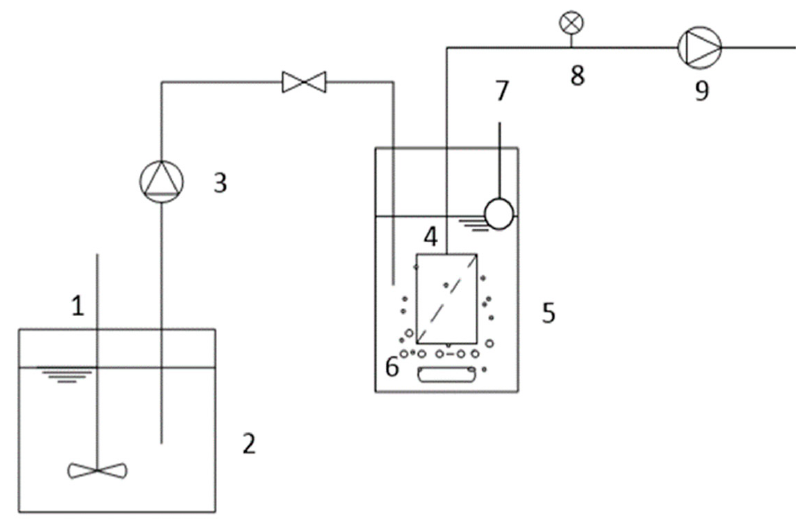
Figure 2. The oxic membrane bioreactor (O-MBR) system (System 2). The system consisted of (1) an agitator; (2) a feed tank; (3) a feed pump; (4) a membrane; (5) an aerobic tank; (6) an air diffuser; (7) a water level controller; (8) a pressure gauge; and (9) a permeate pump.